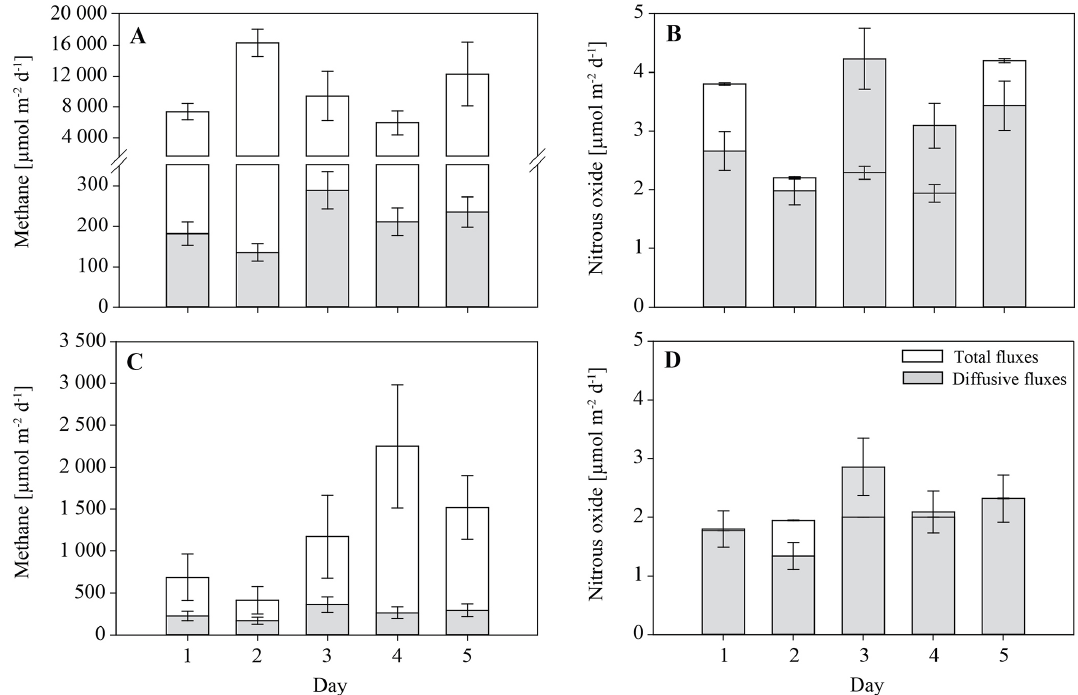
Figure 2. Total and diffusive methane and nitrous oxide fluxes at the shallow sampling site s4 (a, b) and the deep sampling site d7 (c, d) determined over 5 consecutive days. Total fluxes were determined from measurements using the anchored surface floating chambers, and diffusive fluxes were determined using the thin boundary layer model. Fluxes are given as averages ± SE, n = 6.